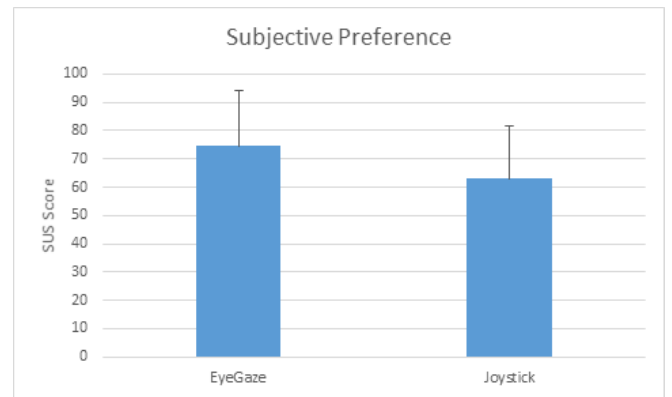
Figure 24. Comparing preference in terms of average SUS scores.